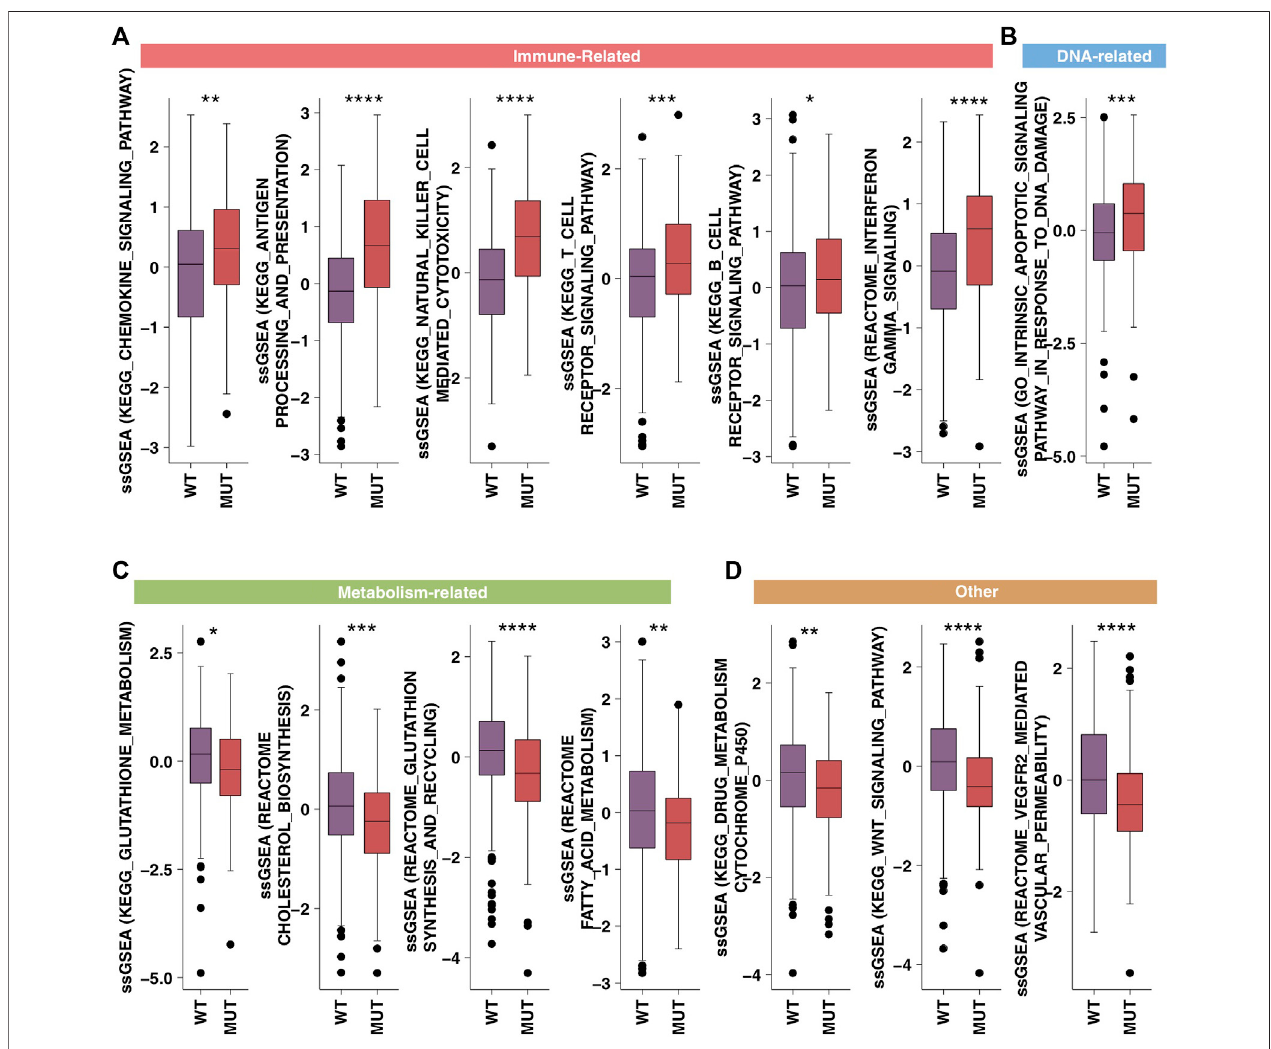
FIGURE 6 | The ssGSEA results. A comparison between the ssGSEA scores in the category of immune-related (A) , DNA-related (B) , metabolism-related (C) and tumor metastasis/growth related (D) of the HR-MUT and HR-WT based on the ssGSEA algorithm (* p < 0.05; ** p < 0.01; *** p < 0.001; **** p < 0.0001).